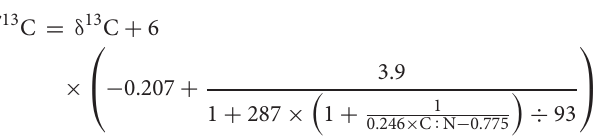
standard ( − 31.02 ± 0.13‰ for δ 13 C; 0.33 ± 0.13‰ for δ 15 N)